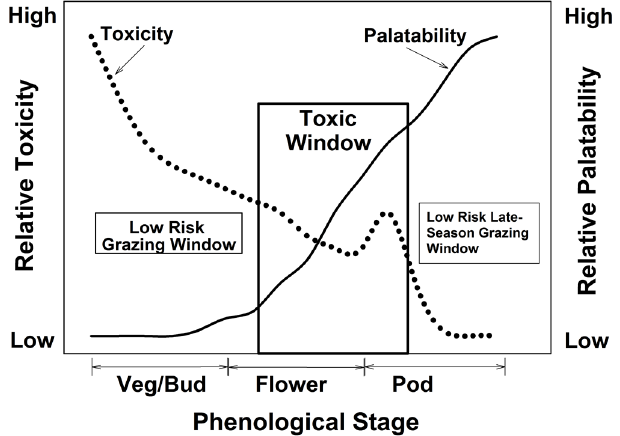
Figure 6. Relationship between toxicity and palatability in tall larkspurs. Most cattle deaths are predicted to occur during the toxic window when the concentration of norditerpenoid alkaloids is substantial and consumption by cattle increases after flowering racemes